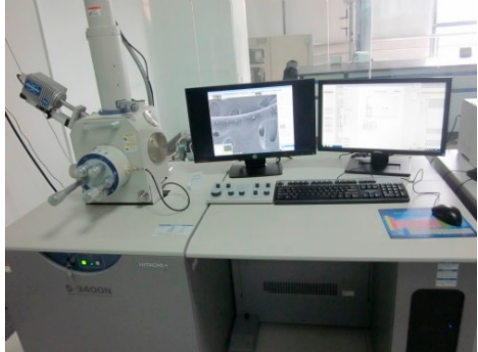
Figure 4. The JSM-6360LV digital scanning electron microscope.